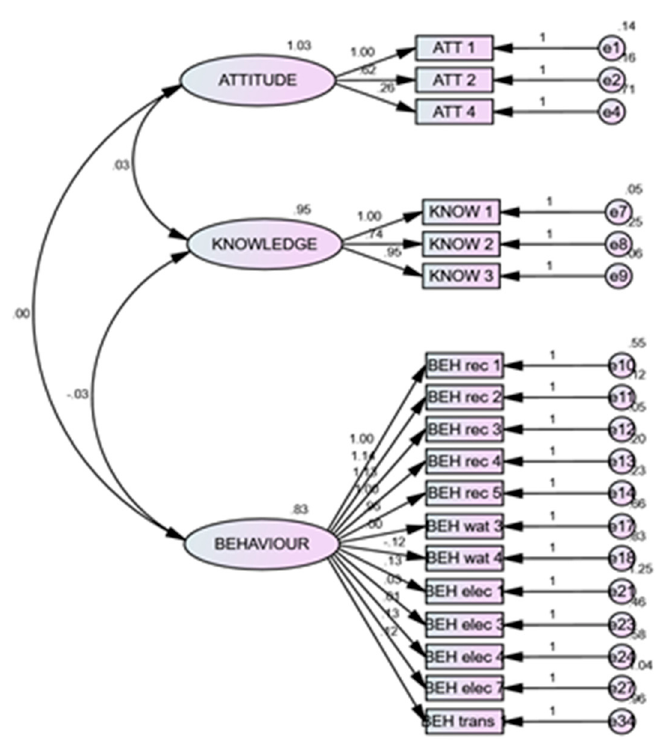
Figure 7. Conceptual measurement model of interrelation between building occupant environmental AKB after Step 1. t < 12 × s(s + 1)